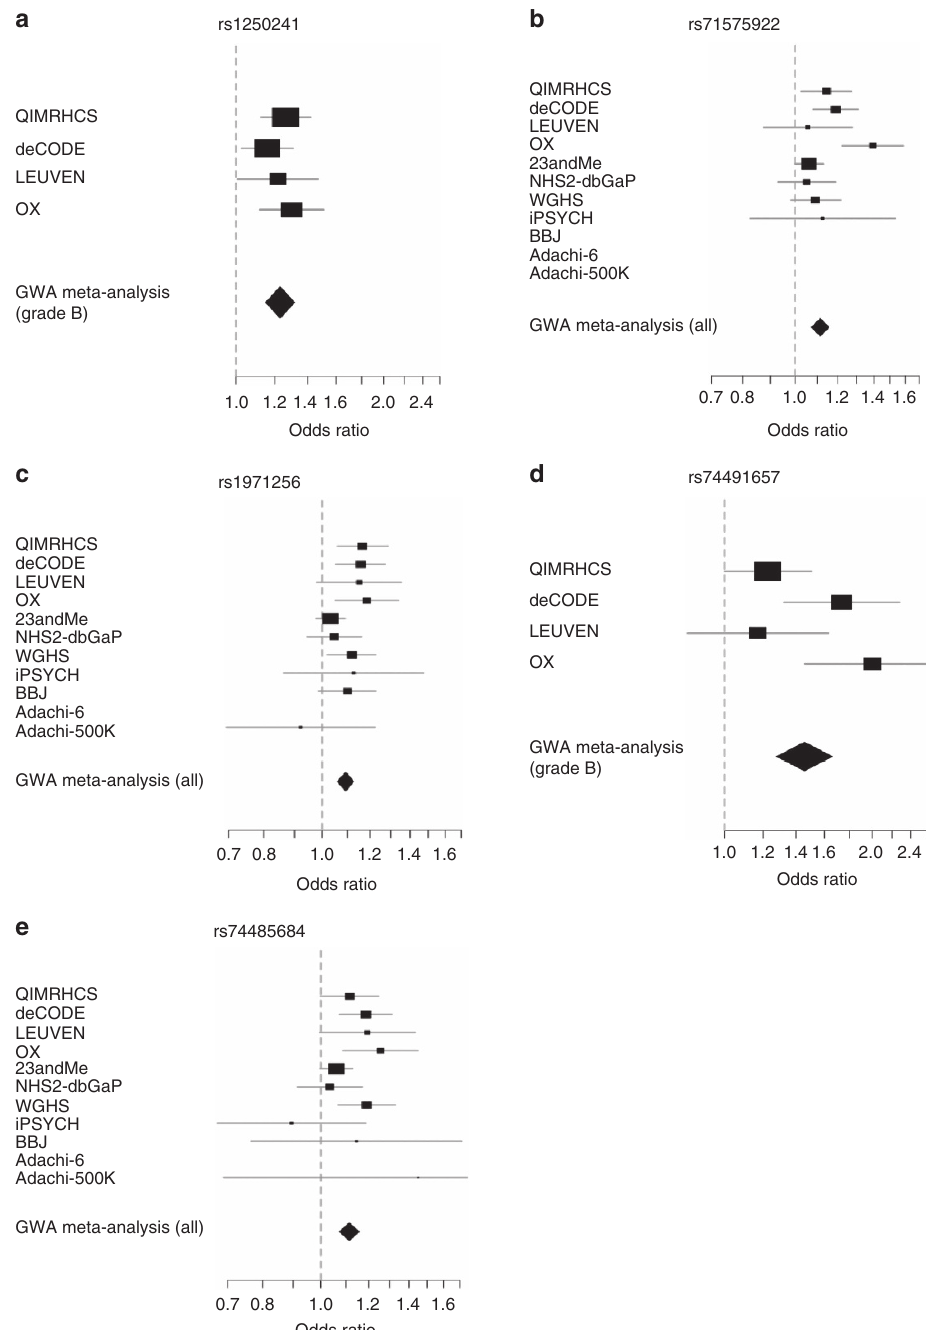
Figure 3 | Forest plots showing risk allele effects for five endometriosis loci. Risk allele effects for the five new genome-wide significant loci in the individual case-control data sets and GWA meta-analysis: FN1 2q35 (3a), CCDC170 on 6q25.1 (3b), SYNE1 on 6q25.1 (3c), 7p12.3 (3d), and near FSHB on 11p14.1 (3e). Results for 2q35 and 7p12.3 are based on analysis including only moderate-to-severe (’Grade B’) endometriosis cases. Risk allele effects of the remaining three SNPs are from analysis including all endometriosis